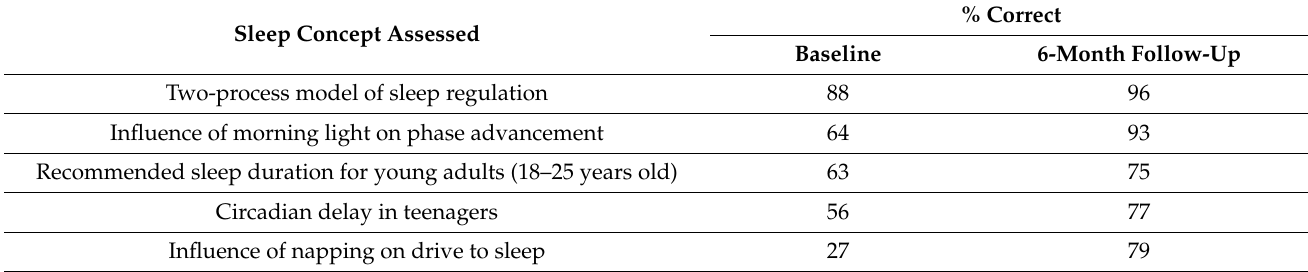
Table 2. Key concepts assessed via multiple-choice questions before and 6 months after the completion of a sleep and circadian education course ( n =